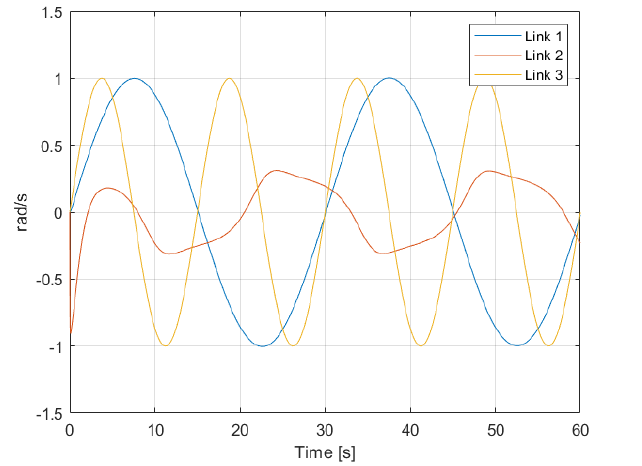
Figure 5. Angular velocity ˙ q of the links in the presence of a sinusoidal torque input.